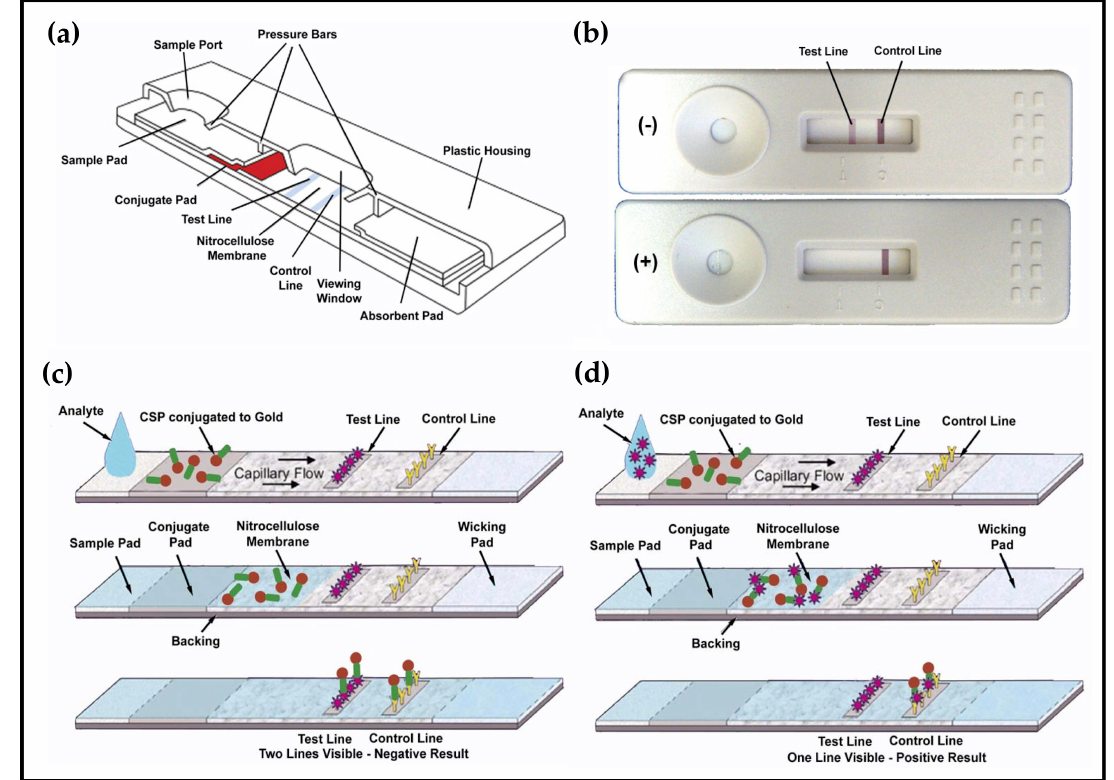
Figure 4. Lateral flow biosensor to detect indole. The detection scheme utilizes rAgamOBP1 that is rendered visible to the naked eye when it is conjugated to colloidal gold. Thus, rAgamOBP1–colloidal gold conjugate lines were striped onto a nitrocellulose membrane sandwiched between sample and conjugate pads. Detection of indole is based on the competition between any indole present in a given sample to be tested and the synthetic ligand in the test line. A positive result is reflected by the loss of a visible test line on the device and indicates that indole is present in the tested sample. Therefore, the device displays only the control line for a positive result. When testing a sample lacking indole, the device displays two lines—the test line and the control line. ( a ) Cut-away diagram of a standard lateral flow device. ( b ) The indole biosensor device. The sample that was added to the upper cassette (-) contained only PBS and shows how a negative result appears (2 lines visible). The sample added to the lower cassette ( + ) contained PBS plus indole (100 ppm) and demonstrates a positive result (only control line visible). ( c , d ) Operating principles of the lateral flow indole biosensor. In ( c ) the control (PBS) result is shown. Since no ligand is present in the analyte, the rAgamOBP1–colloidal gold conjugate is free to bind the test line as well as the control line. A positive result is shown in ( d ). The indole in the analyte binds the rAgamOBP1–colloidal gold conjugate and prevents binding to the test line; therefore, only the control line is